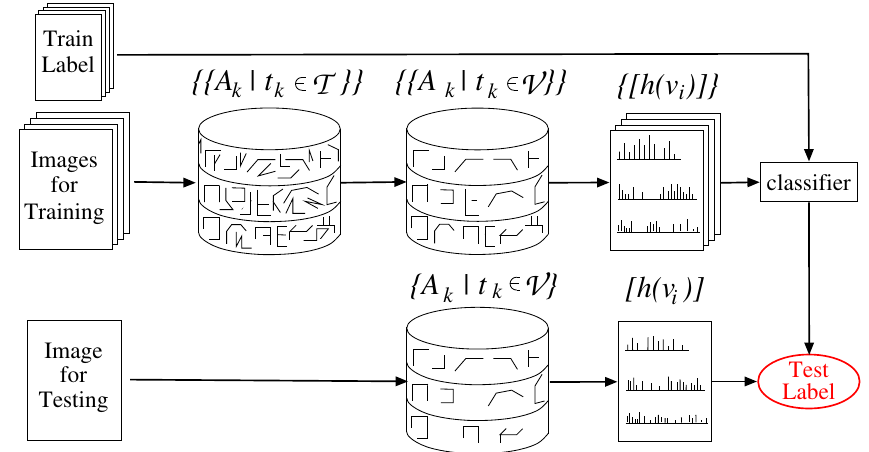
Figure 2: The scheme: Starting from labelled training images, we derive a set { A k } of aggregates A k with general type t k ∈ T for each image and select those aggregates that belong to relevant types t k ∈ V . The vocabulary V has I elements. We use the histogram h = [ h ( v i )] of the aggregates of each image as a feature vector for the supervised classification. Given a test image we derive the relevant features and use their histogram for deriving its label.